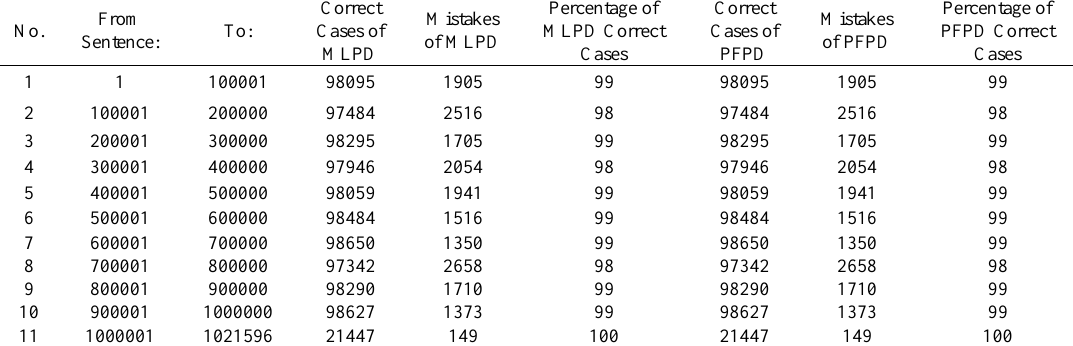
Table 2. Results of comparison made between each sentence and original source.